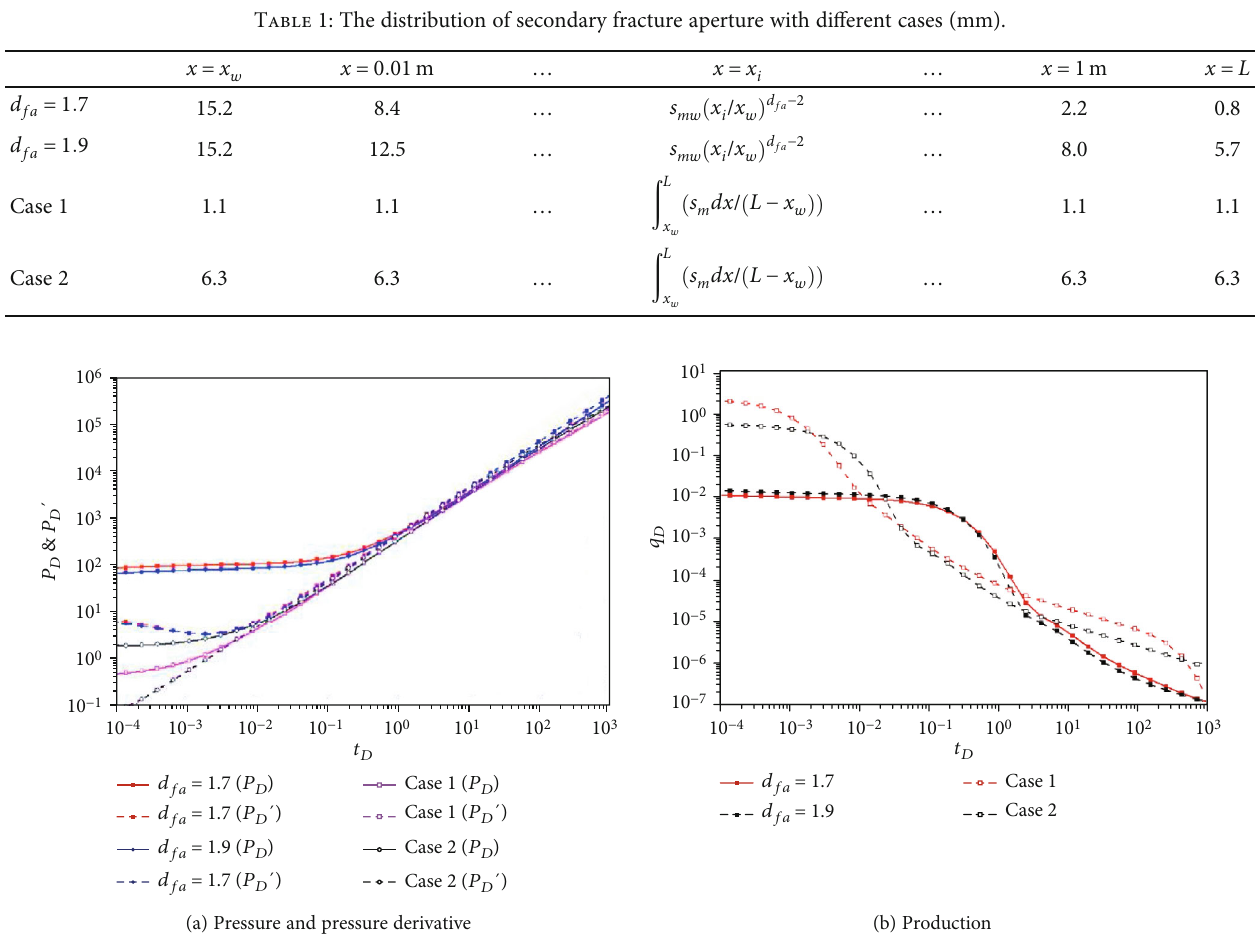
Figure 2: In fl uence of secondary fracture aperture on pressure and production. Table 2: The distribution of secondary fracture spacing with di ff erent cases